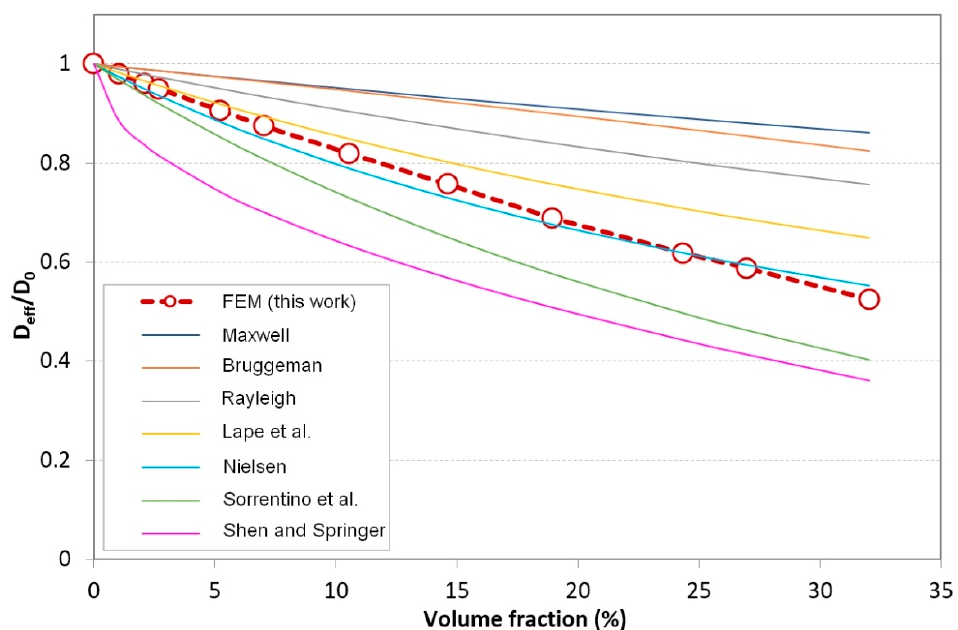
Figure 4. Comparison between simulation results and analytical models [8,43–46,48,49] from the literature (monodisperse fillers: D = 35 nm, L = 177 nm, α = 5).